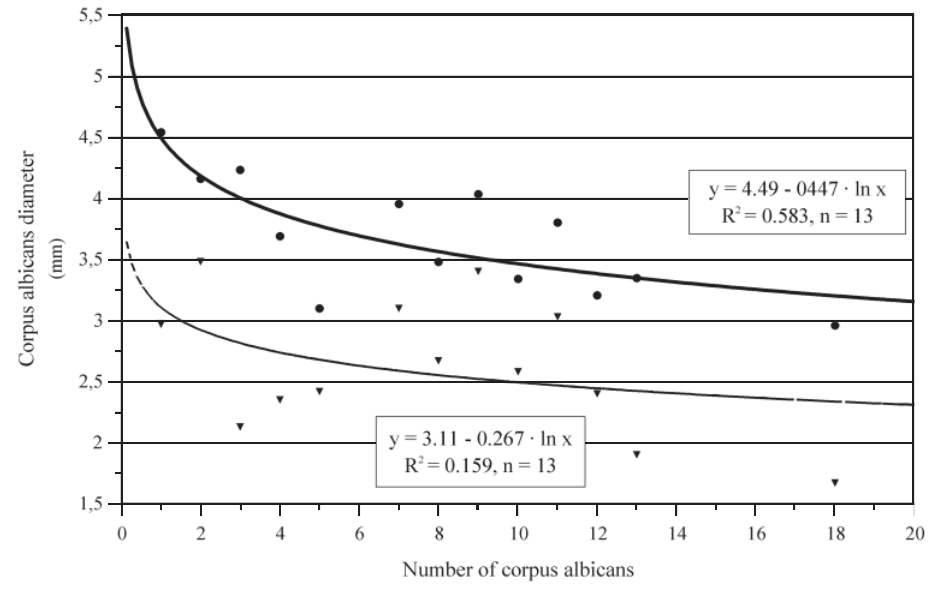
Fig. 7. Relationship between corpus albicans diameter and total number of corpora albicantia in mature animals. ( (cid:2) ) average size, ( (cid:3) ) minimum size. Line shows regression described by the equation for average